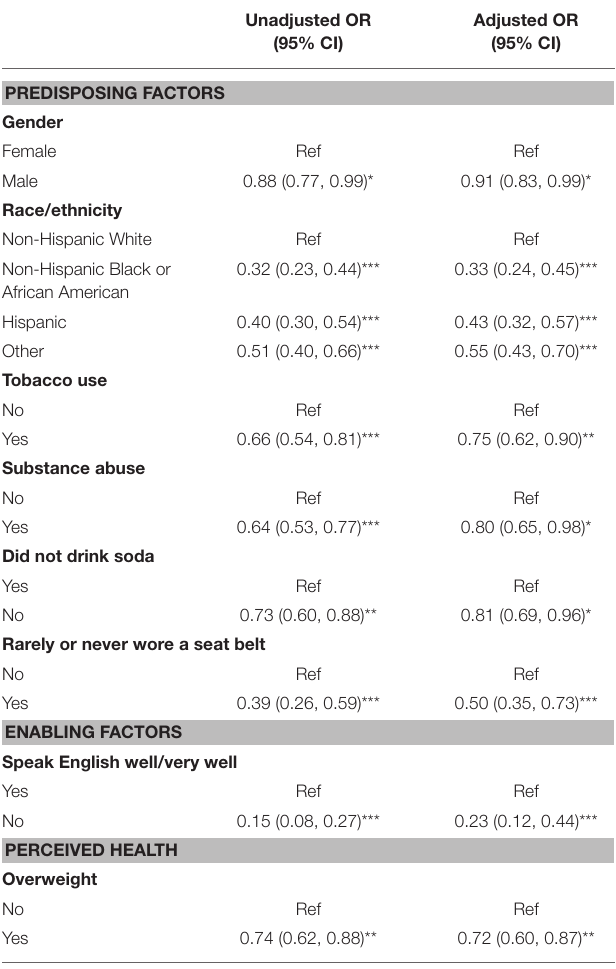
TABLE 2 | Significant variables in multivariable logistic regression model predicting youths’ dental health visits based on Healthcare Utilization